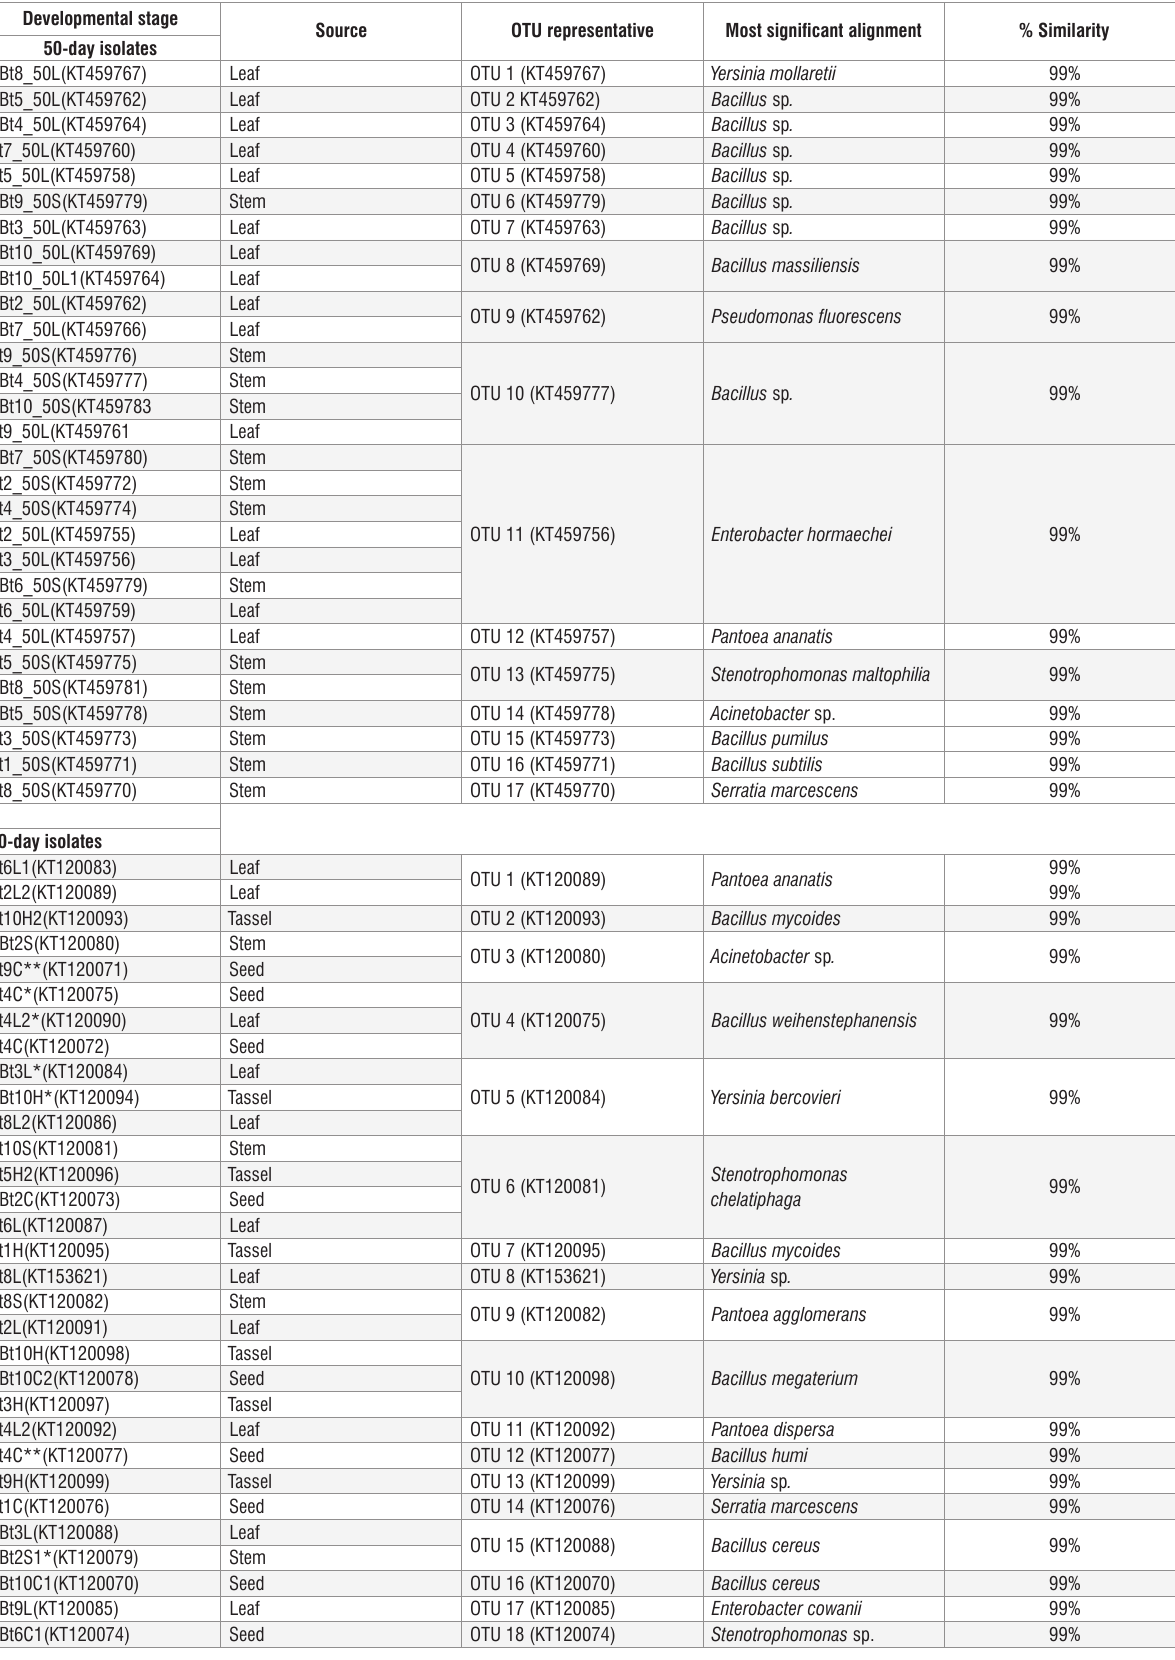
Table 1: Isolates obtained from explant tissues of 50- and 90-day-old Bt and non-Bt maize Developmental